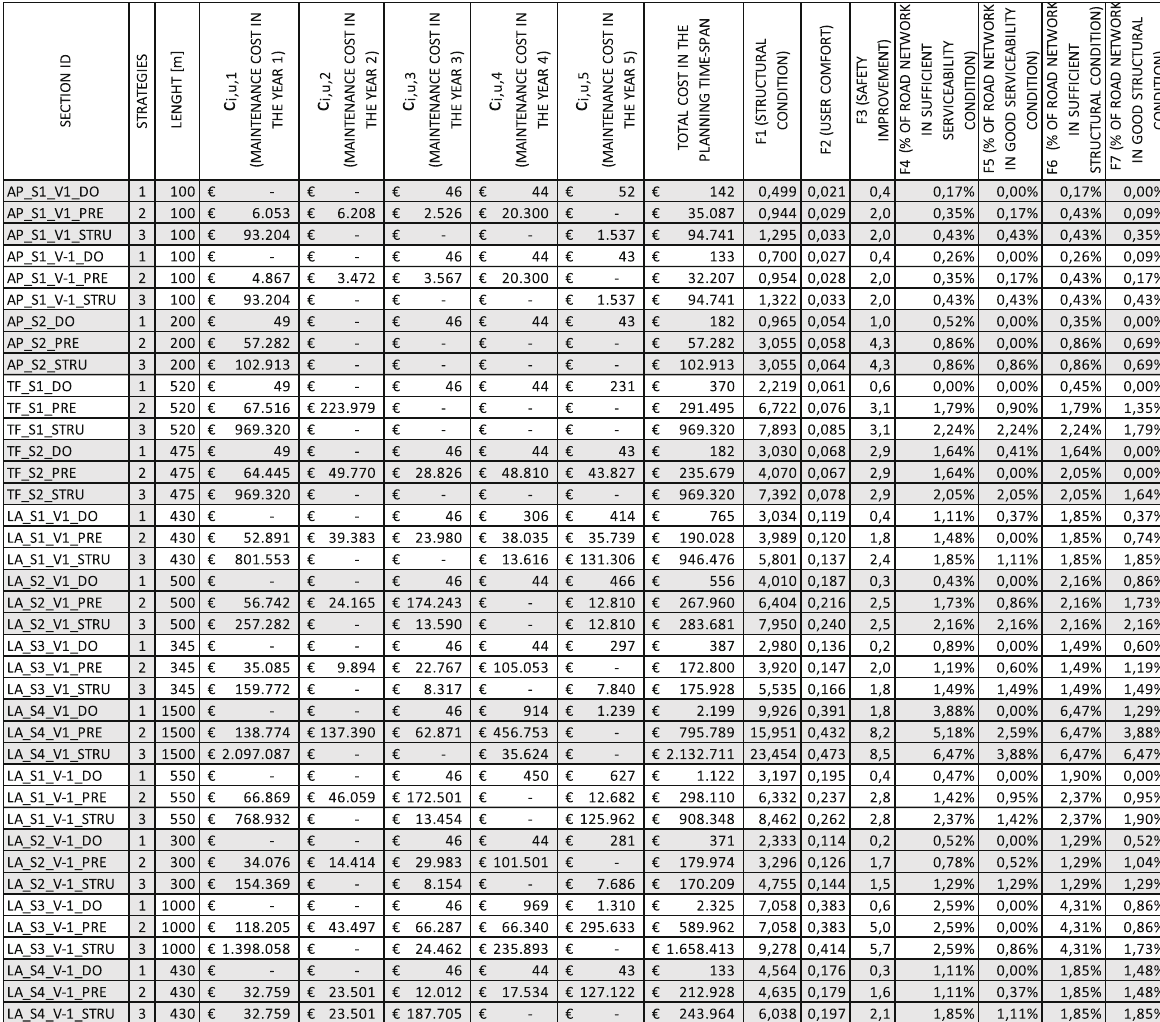
Table 1 Performances and costs obtained on some sections implementing every considered